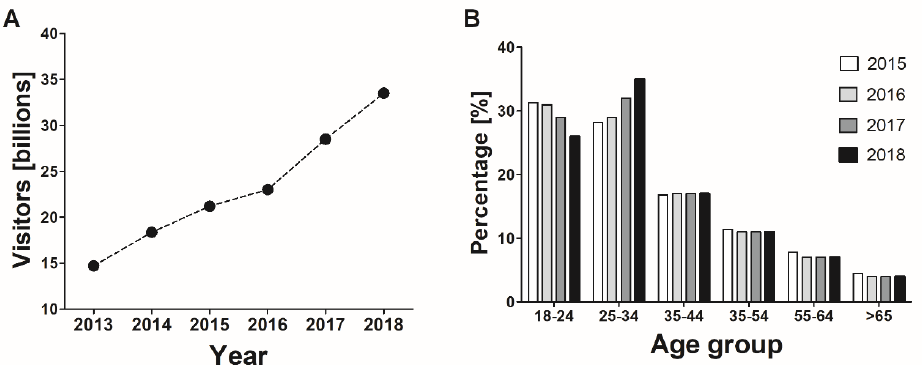
Figure 1. Statistics of pornography use in the period of 2013–2018 according to data shared by Pornhub: ( a ) annual number of visitors to Pornhub, ( b ) visitors to Pornhub by age.